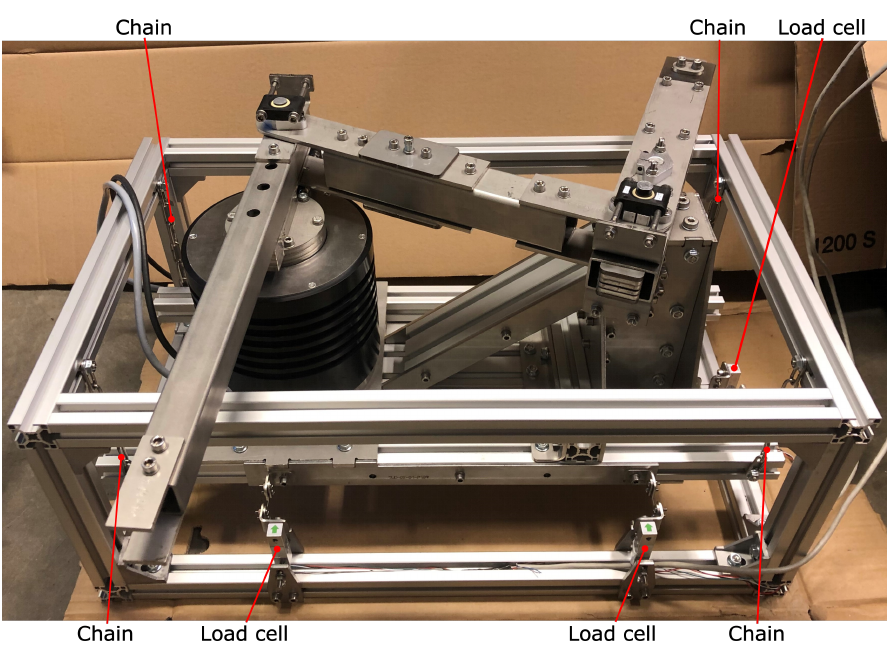
Figure 11. Experimental setup of the balanced manipulator arm with its base suspended by chains and mounted to the load cells for measurements of the in-plane shaking forces and shaking moment.